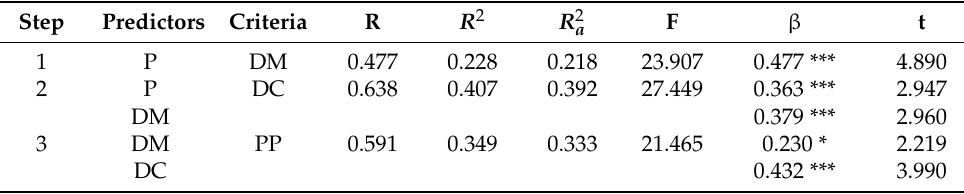
Table 6. Test of mediated relationships among conceptual model components.